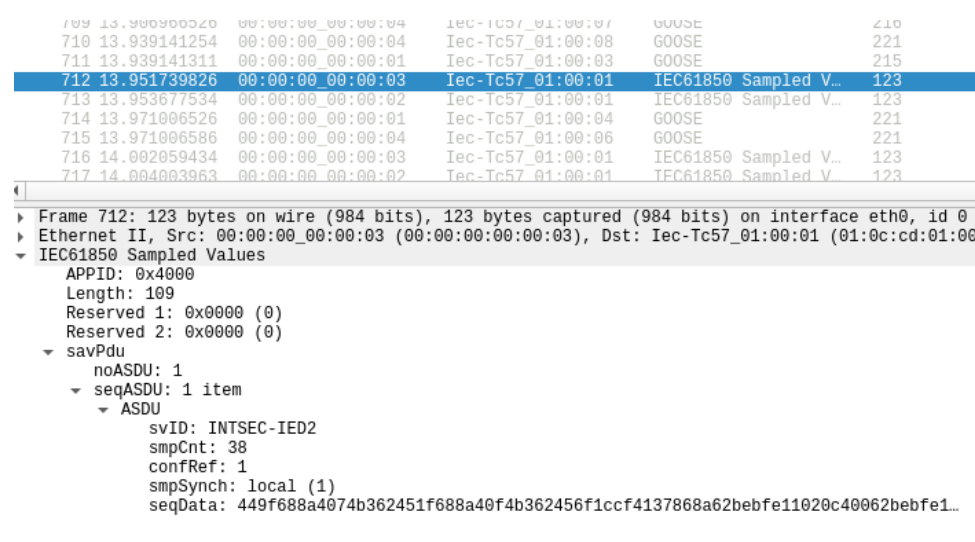
Figure 7. Captured